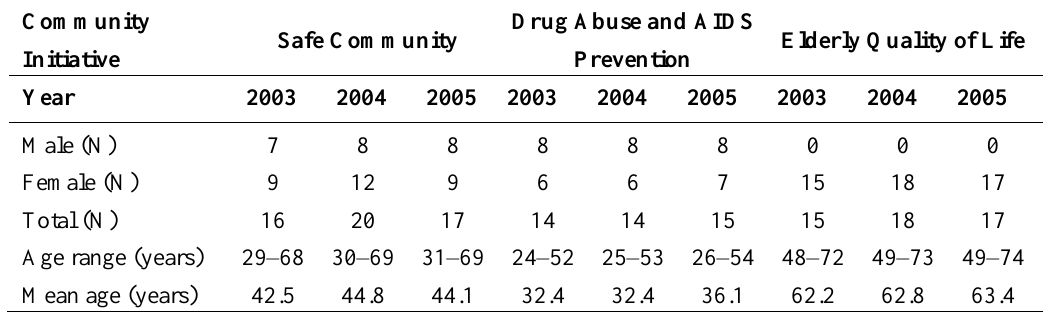
Table 5. Distribution of the gender and age characteristics of the workshop